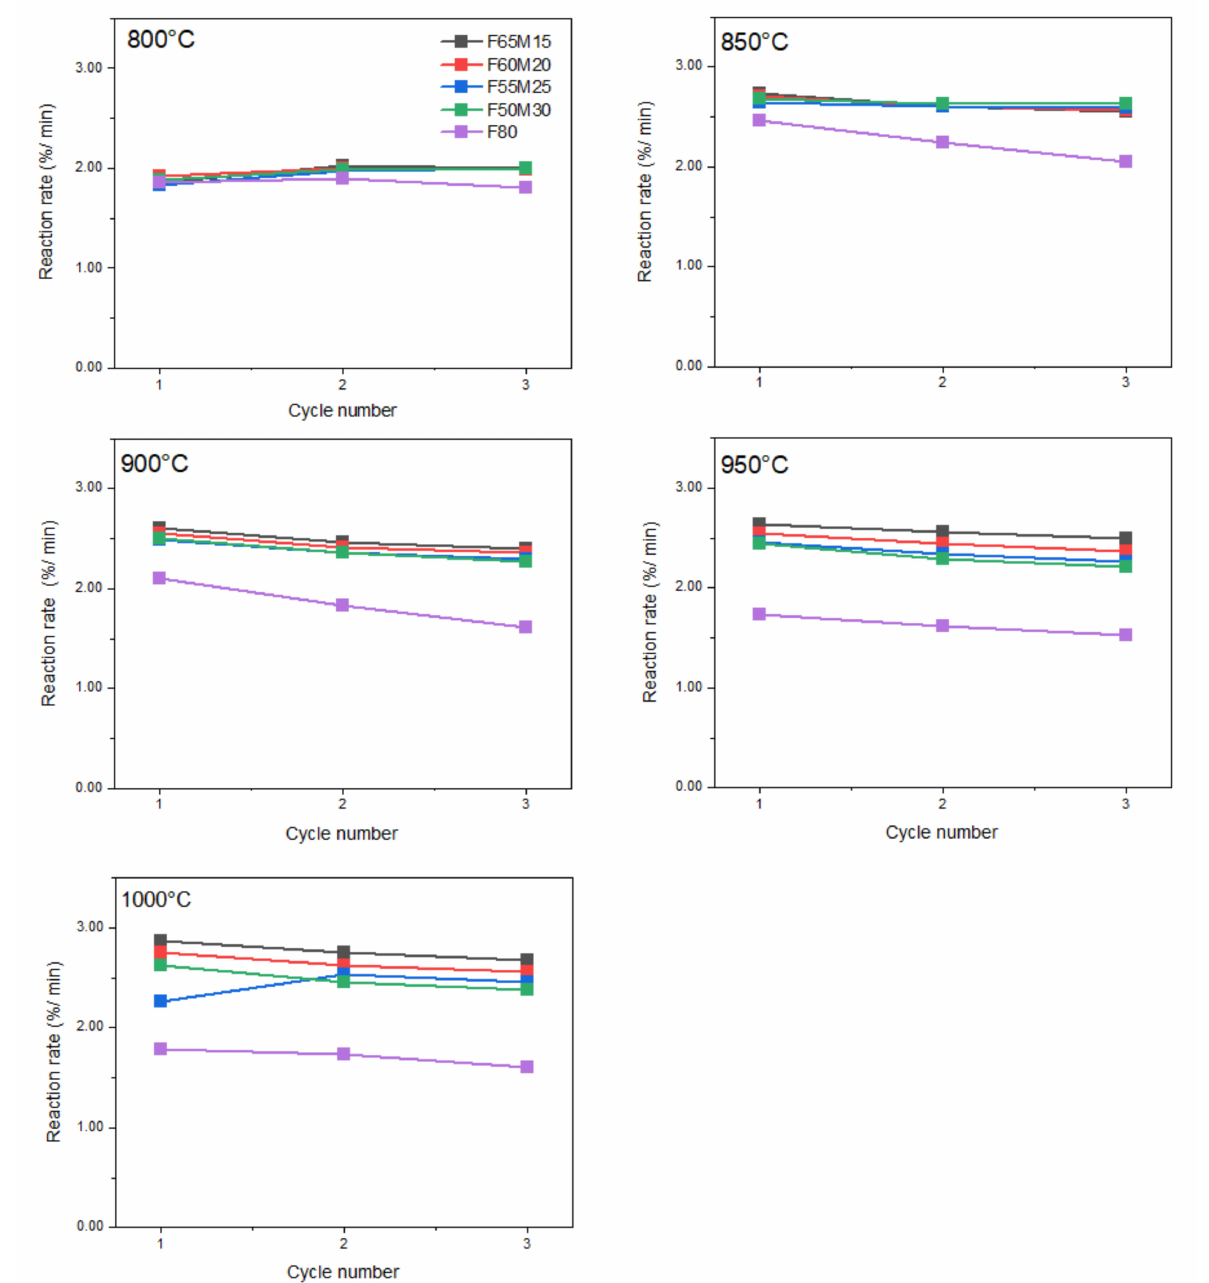
Figure 6. Reduction reaction rates for OCs versus cycle number at given temperatures 800–1000 ◦